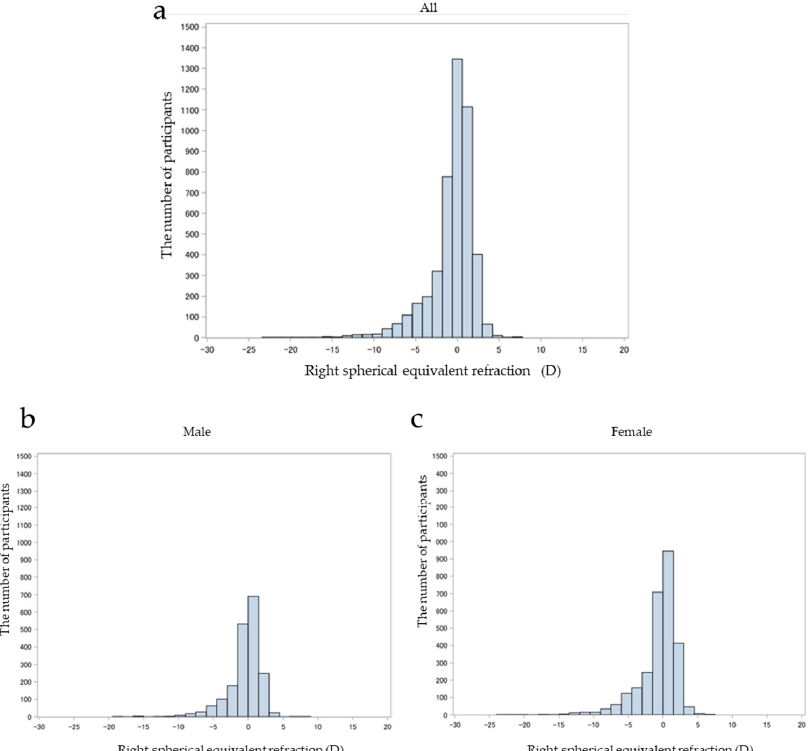
Figure 2. Distribution of spherical equivalent refraction in Chikusei-city: ( a ) the distribution map shows the spherical equivalent refraction of the right eye in the subjects, ( b ) spherical equivalent refraction of the right eye in men subjects, and ( c ) spherical equivalent refraction of the right eye in women subjects. Table 1. The association between systemic and ocular features and high